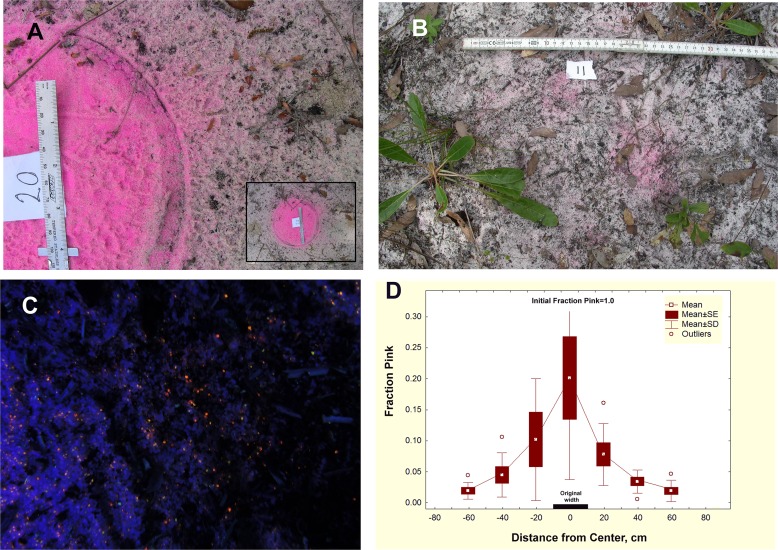
The spreading experiment after three elapsed times.A. Representative disc of colored sand on March 20, 2012, 20 days after emplacement. Note the haze of pink grains that has dispersed well beyond the original disc boundary. The agents of transport are probably wind and water, but possibly also animals. Note the raindrop pitting especially visible on the disc. Inset shows entire disc. B. Appearance Sept. 21, 2012. approx. 7 months after emplacement. C. A disc of fluorescent sand 2 years after emplacement, under UV light in situ. The color of the disc was no longer visible without the aid of UV fluorescence. D. Distribution of pink grains in the spreading experiment, March 11, 2013, one year after emplacement of 500 g of 100% pink sand in a disc 20 cm in diameter. Within a year, significant amounts of pink sand have spread more than 50 cm from the edge of the original disc.